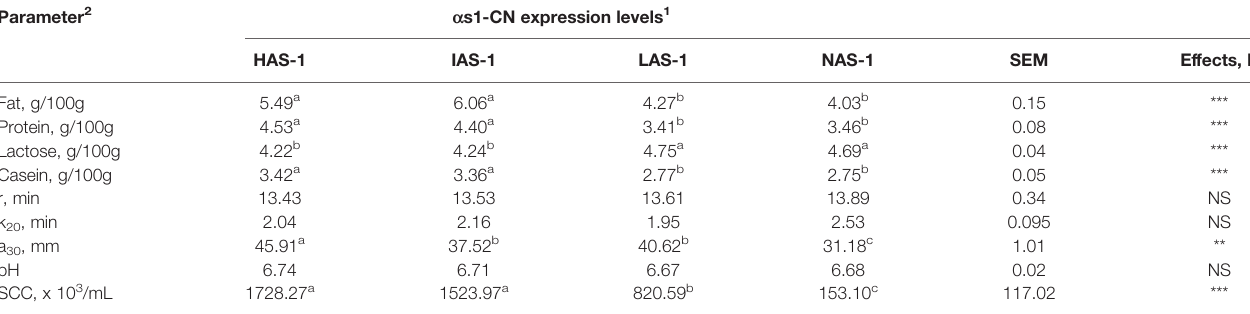
TABLE 3 | Effect of different a s-1 casein expression levels on milk gross composition and clotting parameters. Parameter 2